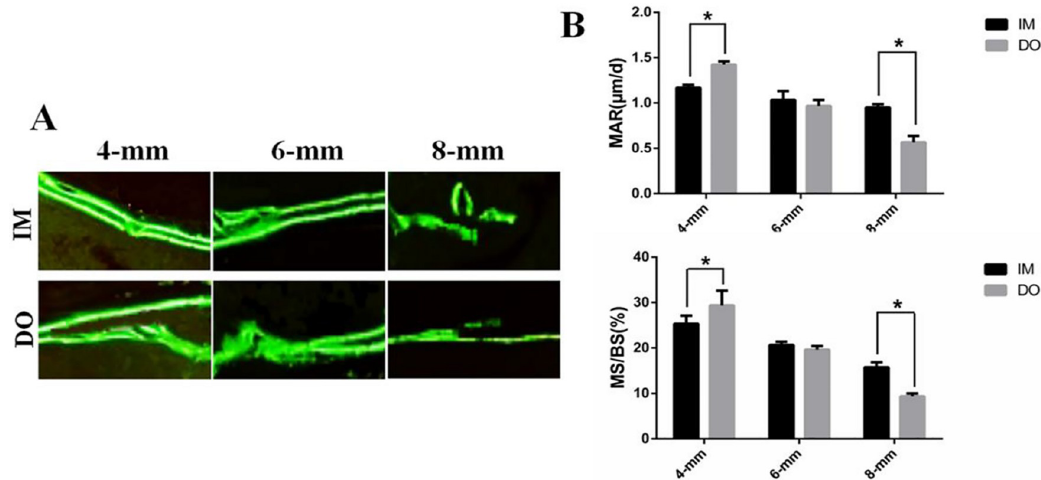
Fig 7. Dynamic bone formation illustrated by calcein double labeling. (A) Representative images of calcein double labeling of newly-formed bone. Original magnification, 200 × . (B) Quantification of mineral apposition rate (MAR) and mineral surface versus bone surface (MS/BS). MAR ( μ m/day) = distance between labels/interlabel period. Horizontal interval of the lines represented the amount of newly-formed bone between the injection interphase. ( � P < 0.05).